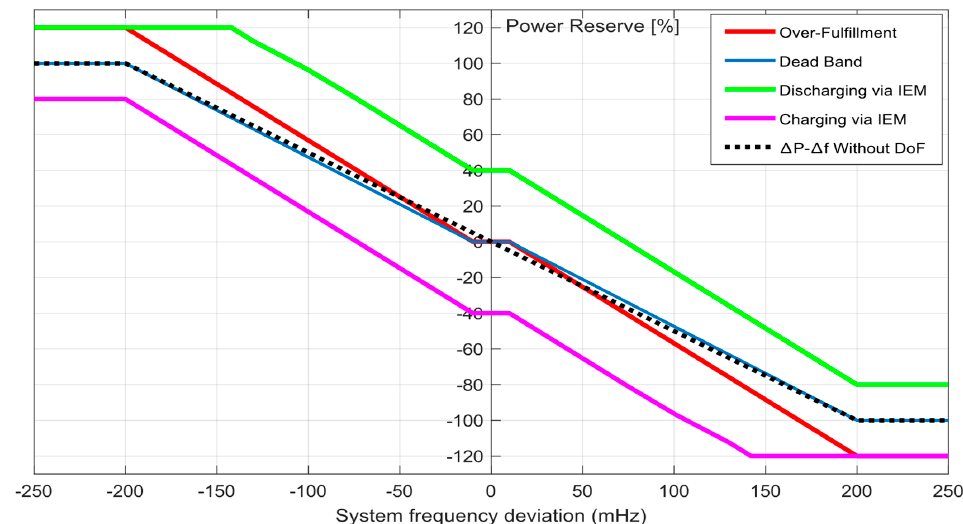
Figure 4. Power to frequency ration ( ∆ P - ∆ f ) characteristics for the provisioned FCP service with demonstrating possible individual degree of freedom (DoF) strategies for the BESS SoC maintenance. IEM: intraday energy market.